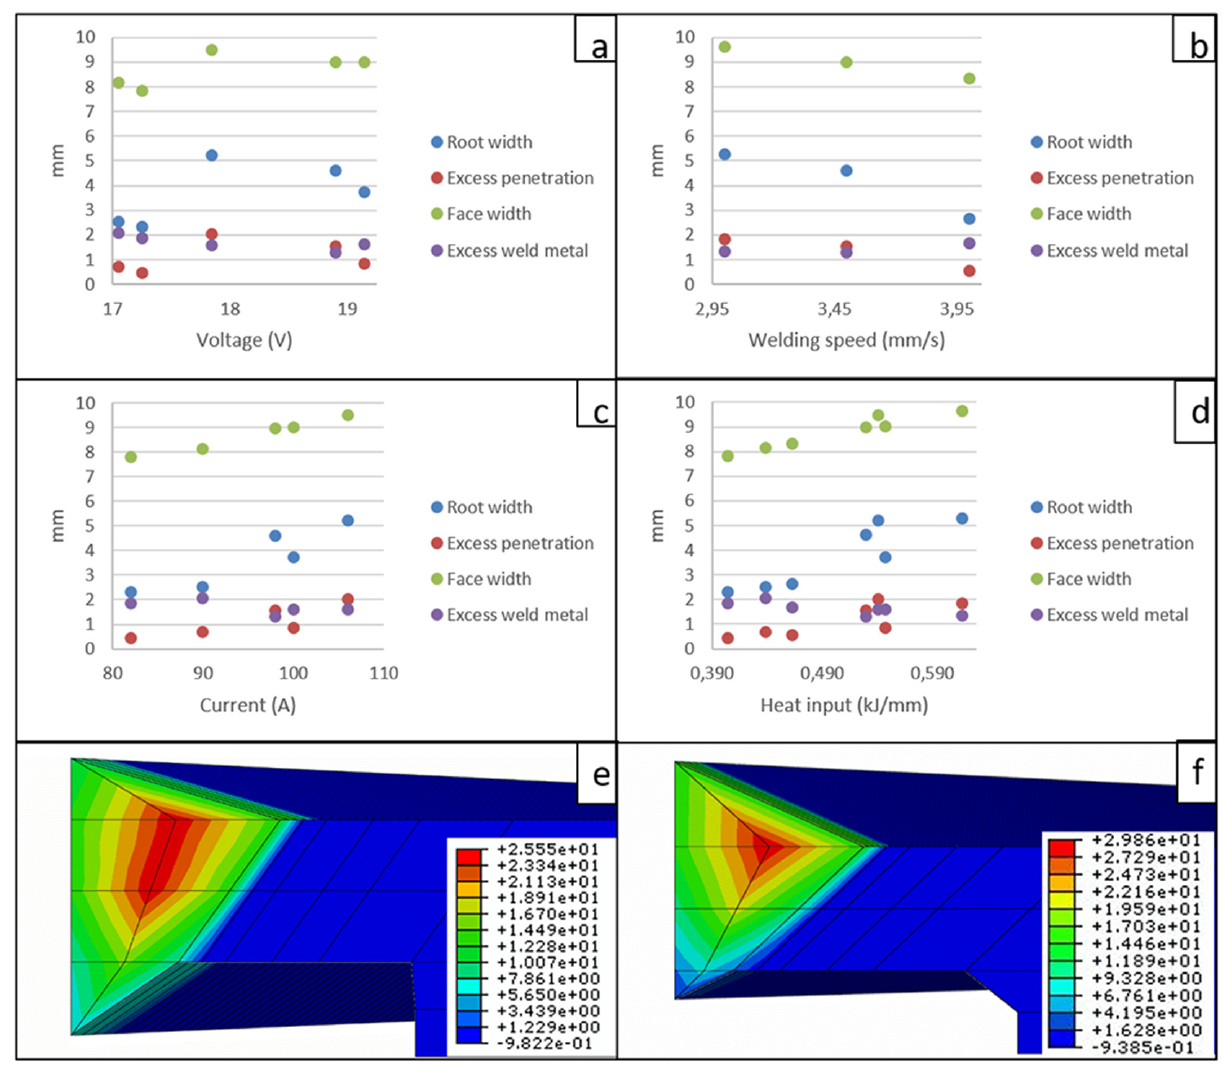
Figure 3. Influence of the parameters on the weld bead dimensions, ( a ) voltage, ( b ) welding speed, ( c ) current, ( d ) heat input, ( e ) heat flow distribution on coupon 1 (lower excess weld metal), ( f ) heat flow distribution on coupon 6 (higher excess weld metal).